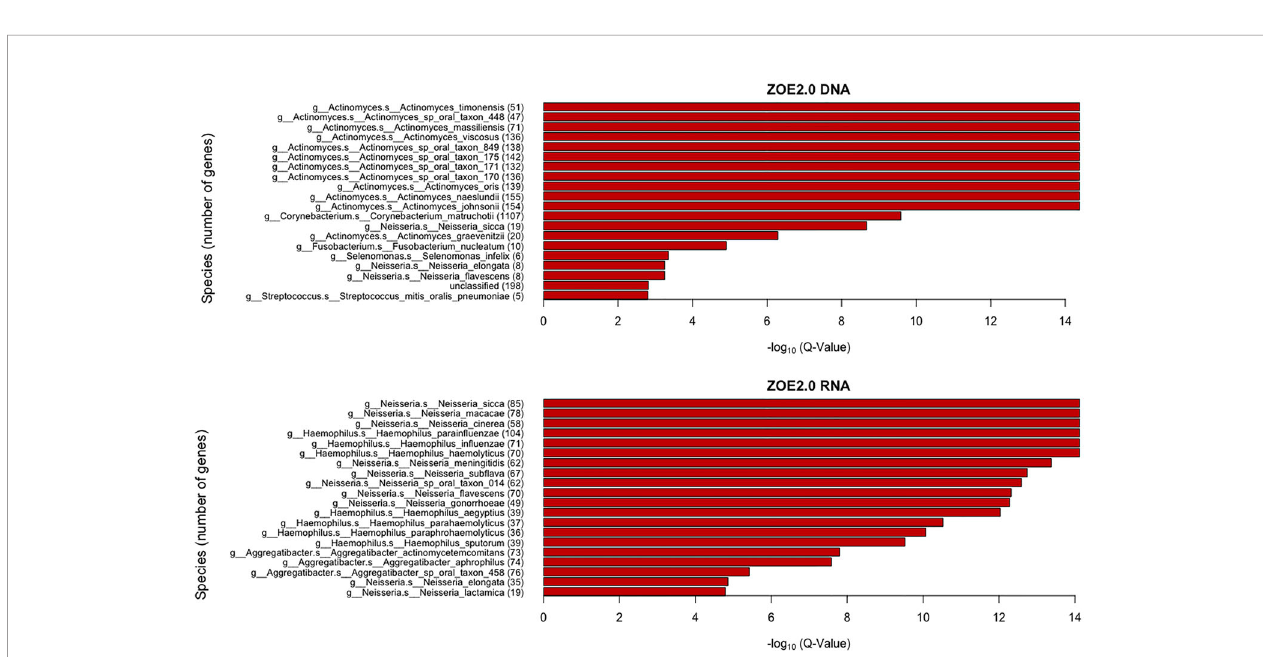
FIGURE 9 | Taxonomic enrichment of metabolite predictive species for the most contributing species to metabolite prediction, based on ZOE 2.0 DNA or RNA by ENVIM. The top 20 signi fi cant over-represented bacteria with the smallest Q -values ( Q < 0.05) for ZOE 2.0 data. The Q -value is based on the Kolmogorov – Smirnov (KS) test p -values after FDR correction. Upper, DNA data; Lower, RNA